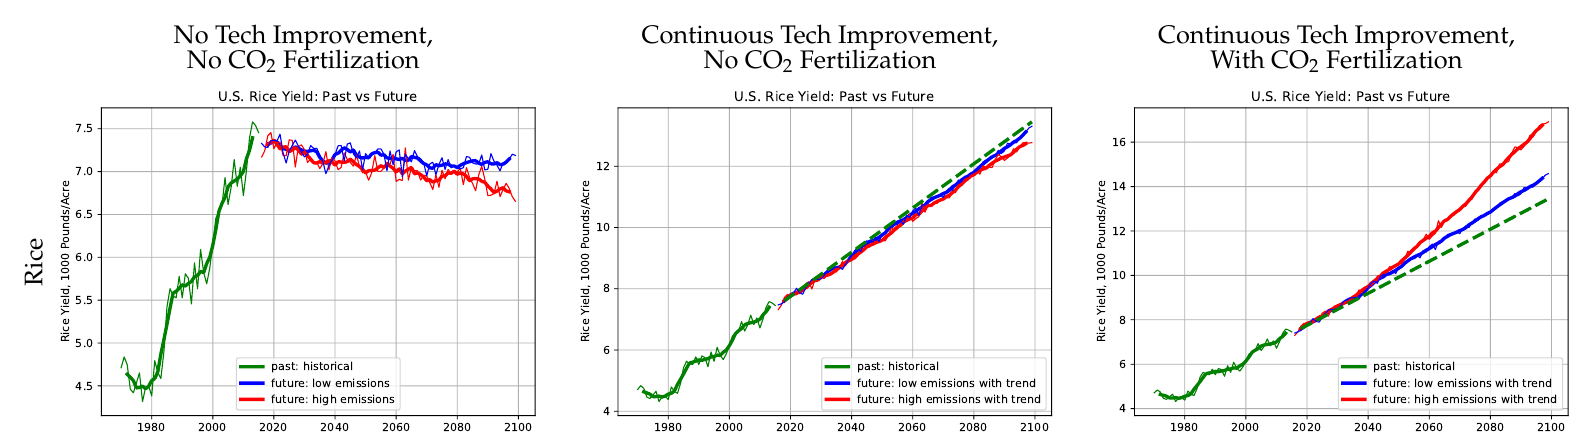
Figure 7. Projected US corn (top), soybean (middle), and rice (bottom) yields to 2100. The prediction scenarios include: (left) no technology improvement and no CO 2 fertilization; (center) continuous technology improvement and no CO 2 fertilization; and (right) continuous technology improvement with CO 2 fertilization. The green dashed line is a linear extension of the 1970–2015 trend. Thin lines are yearly data, solid is the five-year running